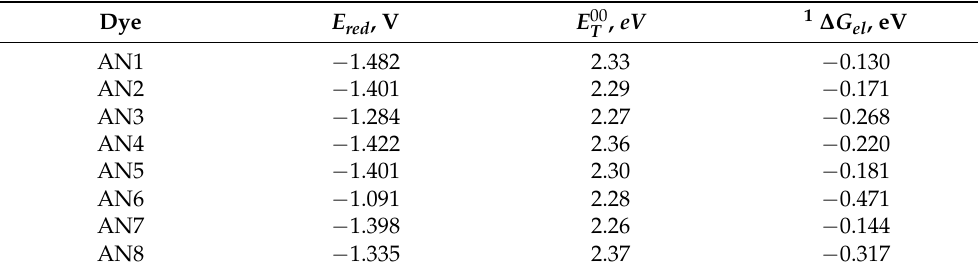
Table 4. The reduction potential ( E red ) of the dyes, transition energy T 1 → S 0 ( E 00 namic potential of an activation of the electron transfer process ( ∆ G el ).